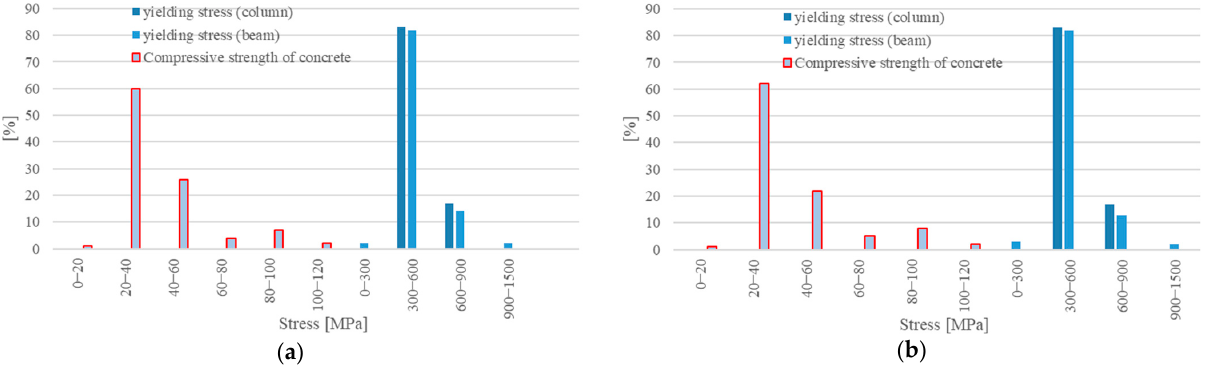
Figure 6. Mechanical performance of material of RC frame elements (column and beams): ( a ) T- shaped RC joints, ( b ) X-shaped RC joints.